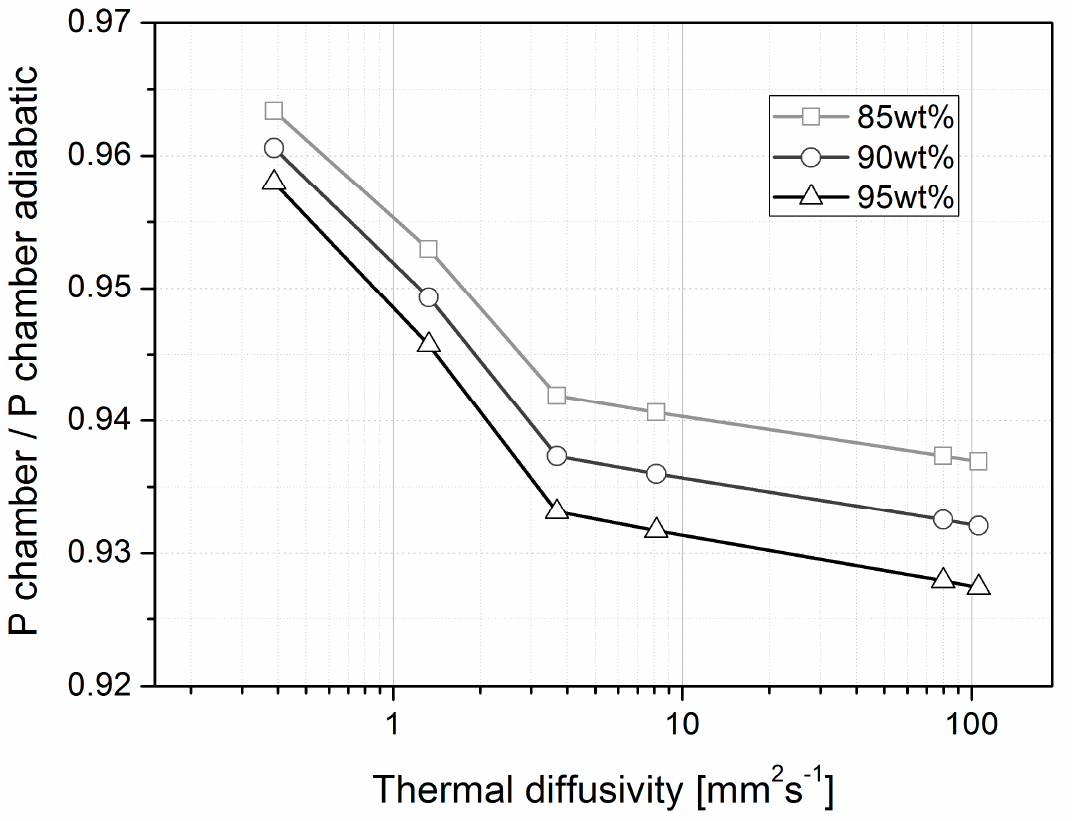
Figure 12. Chamber pressure of microthrusters with different thermal diffusivity materials and different propellant weight percentages (mass flow rate of 7 × 10 − 5 kg/s).